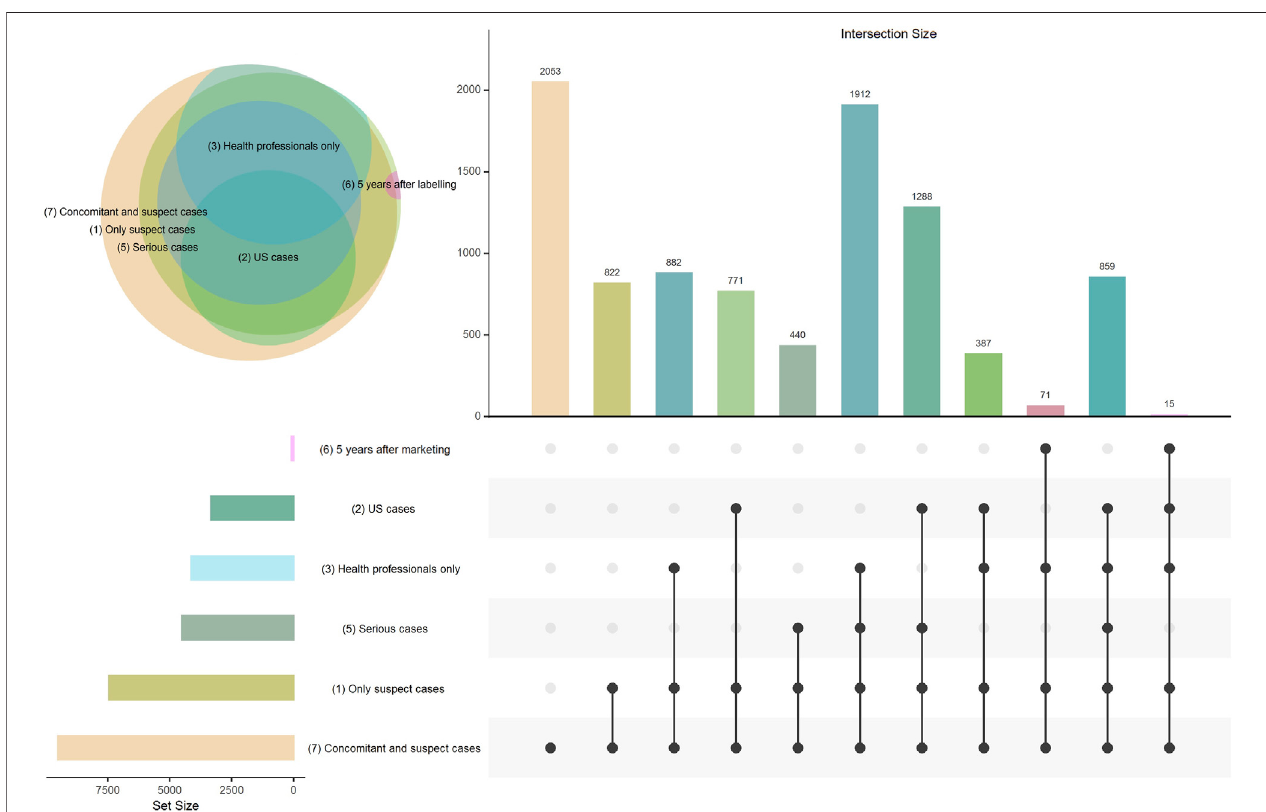
FIGURE 1 | Venn diagram and Upset plot presenting the distribution of cases included in each disproportionality analysis and the overlap between each of the models. Model 4 (subgroups by therapeutic area) is not displayed in the fi gure because only the comparators were modi fi ed in this model (cases correspond to all suspect